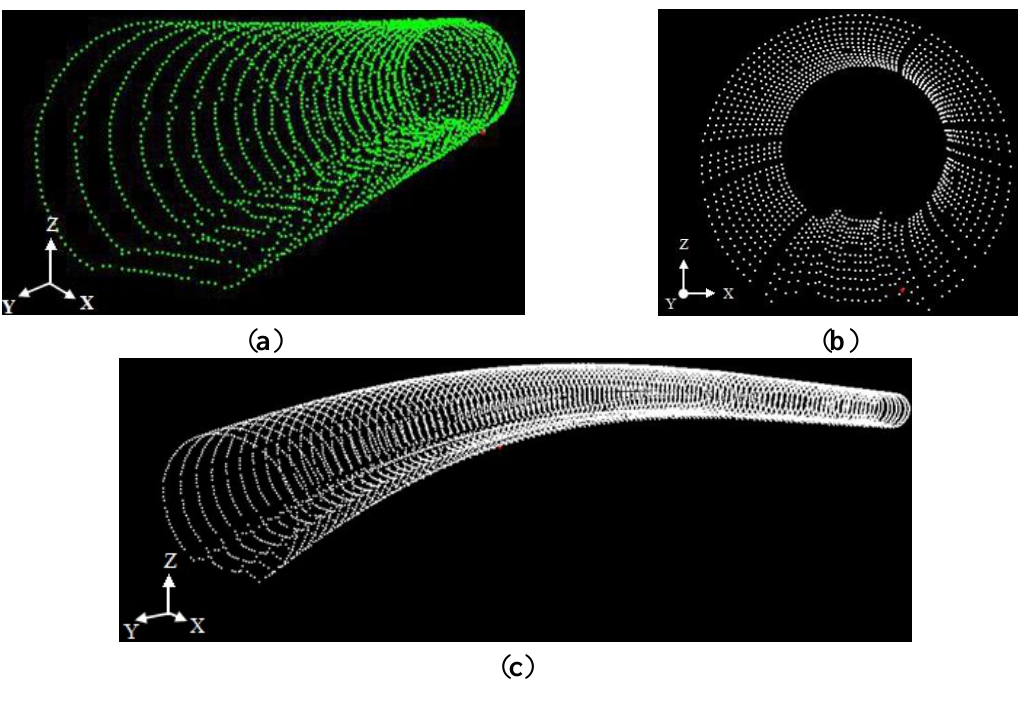
Figure 16. Cross section extraction. ( a ) Interpolated candidate cross-sectional points; ( b ) Real cross-sectional points extracted by RANSAC; ( c ) Overview of all extracted cross sections.